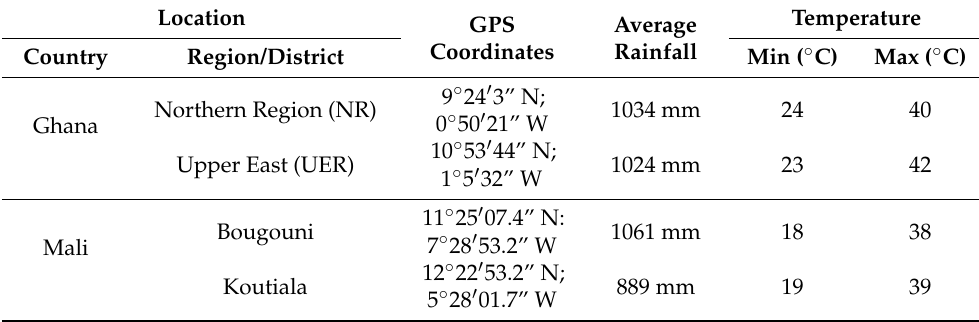
Table 2. Climatic characteristics of trial